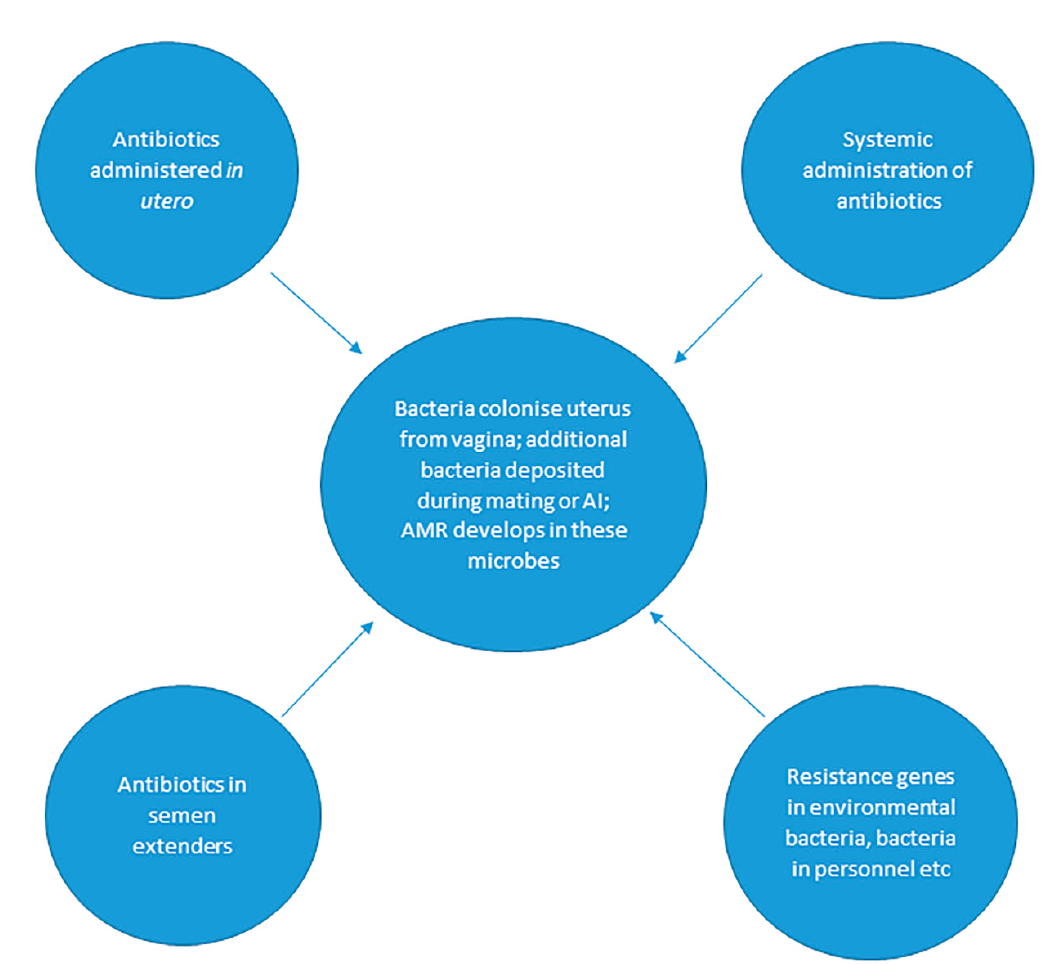
Figure 2. Sources of AMR in the microbial flora of the equine reproductive tract. Note that AMR can develop by any of the mechanisms described in Section 2.